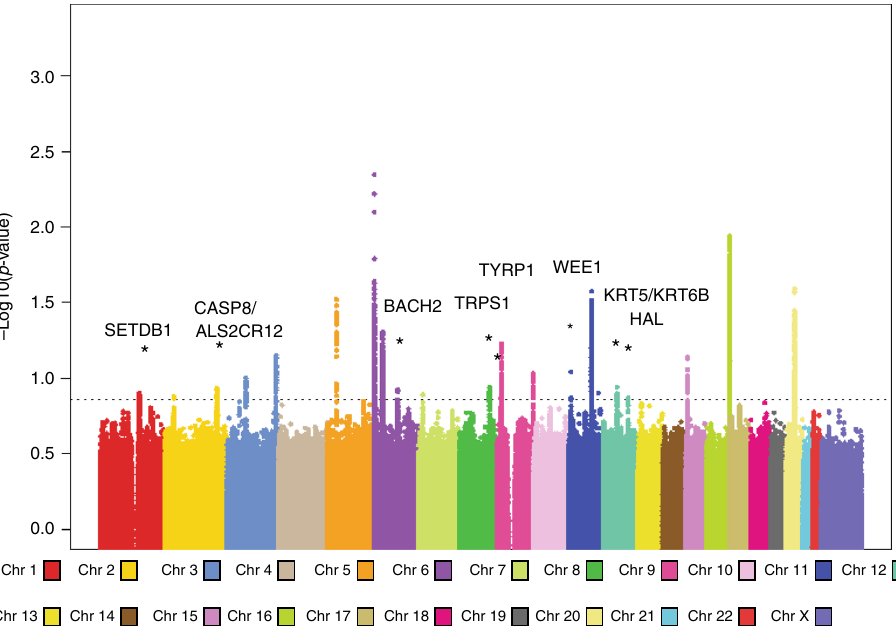
Fig. 1 Manhattan plot of the combined meta-analysis of GWAS of SCC. The P fi xed Stage one value for all SNPs present in at least two studies have been plotted using a − log 10 ( p- value). The total Stage one meta-analysis included eight SCC GWAS, totaling 19,149 cases and 680,049 controls. p < 5 × 10 – 8 (genome-wide signi fi cance) threshold is indicated by a dashed line. In total, 22 loci reached genome-wide signi fi cance, including 8 novel loci 1q21.3, 2q33.1,